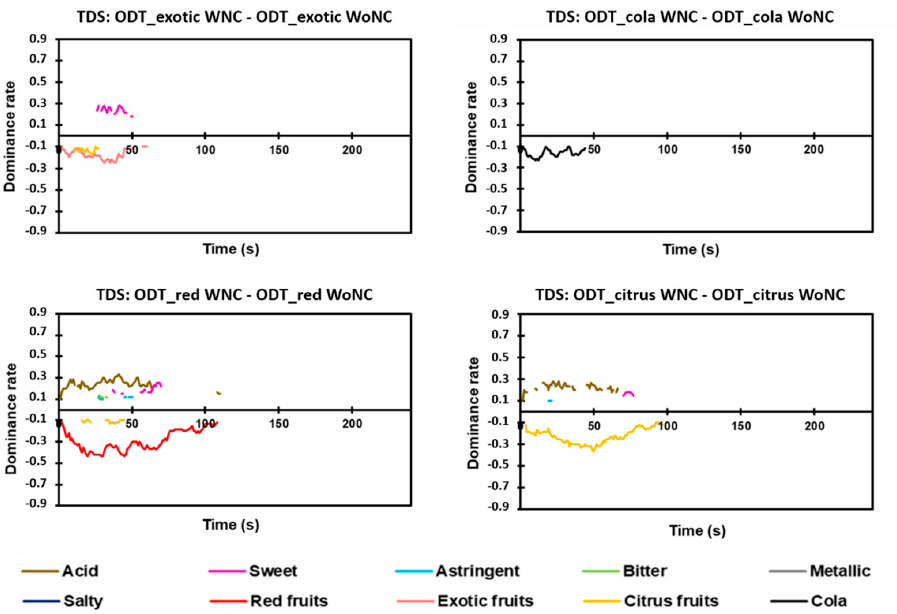
Figure 6. Difference curves for TDS (Temporal Dominance of Sensations) between a given pair of the same product (nose-clip evaluation and without nose-clip evaluation) based on 95% Fisher’s exact test. WNC, with nose-clip. WoNC, without nose-clip.